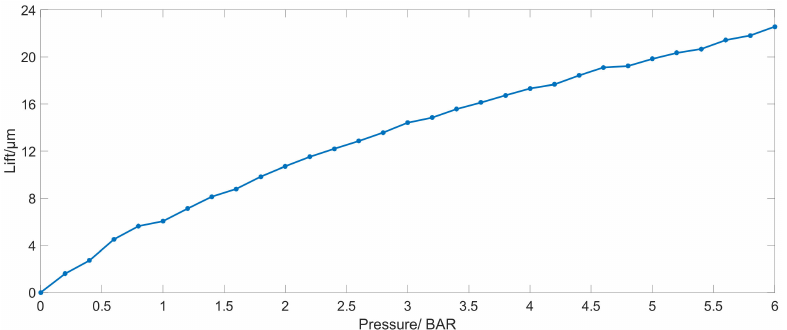
Figure 4. Relationship between pressure and lift for a Ø 25 mm pad (0.4 kg load).